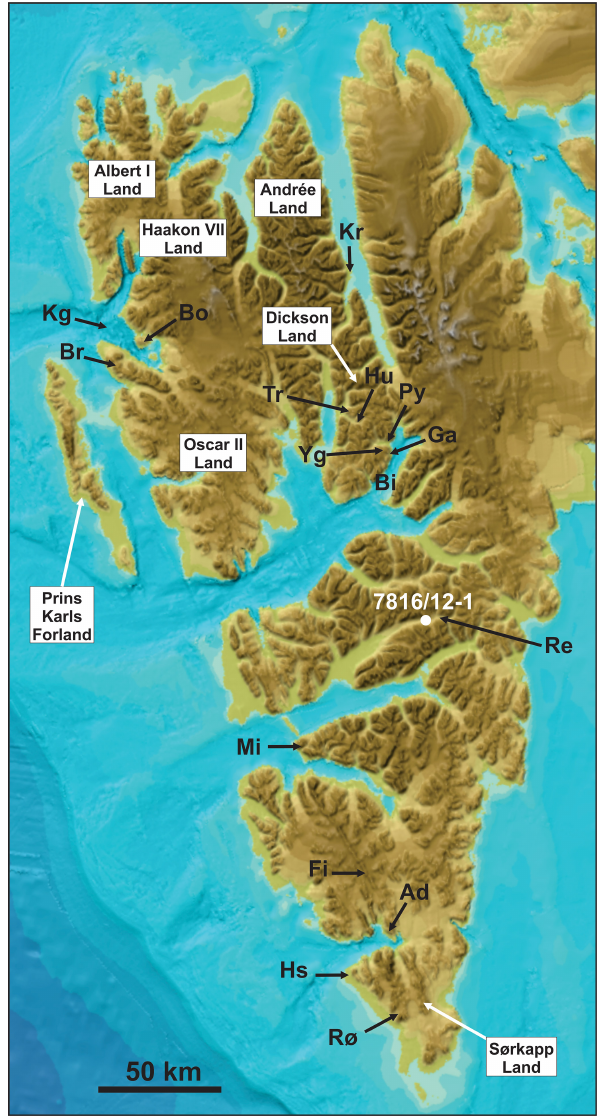
Figure 1. Topographic and bathymetric map around Spitsbergen modified after Jakobsson et al. (2012). The location of exploration well 7816/12-1 is shown in white. Abbreviations are as follows: Ad stands for Adriabukta; Bi stands for Billefjorden, Bo stands for Blomstrandhalvøya, Br stands for Brøggerhalvøya, Fi stands for Fiskeknatten, Ga stands for Garmdalen, Hs stands for Hornsund- neset, Hu stands for Hugindalen, Kg stands for Kongsfjorden, Kr stands for Krosspynten, Mi stands for Midterhuken, Py stands for Pyramiden, Re stands for Reindalspasset, Rø stands for Røkensåta, Tr stands for Triungen, and Yg stands for